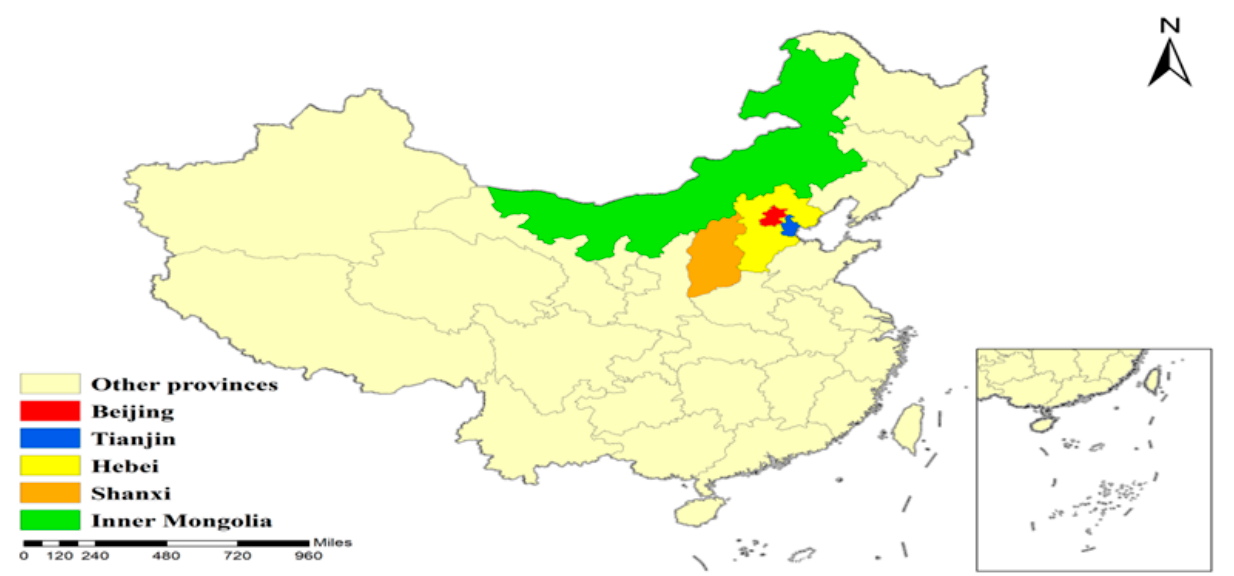
Figure 1. Geographical location of the research area.